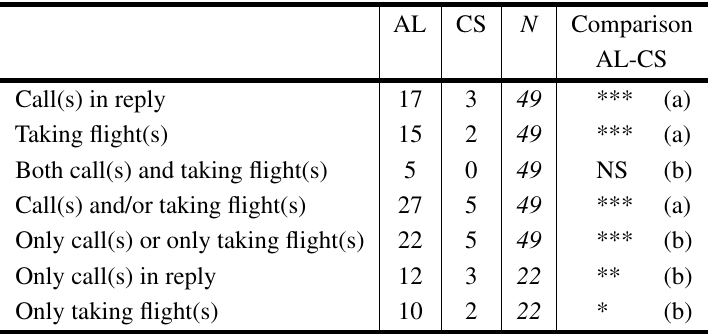
Global population analysis. Number of budgerigars displaying responses to the playback of a conspecific alarm call (AL) or of a control sound (CS). Numbers of responding males (M) and females (F) in spring and in winter are pooled.